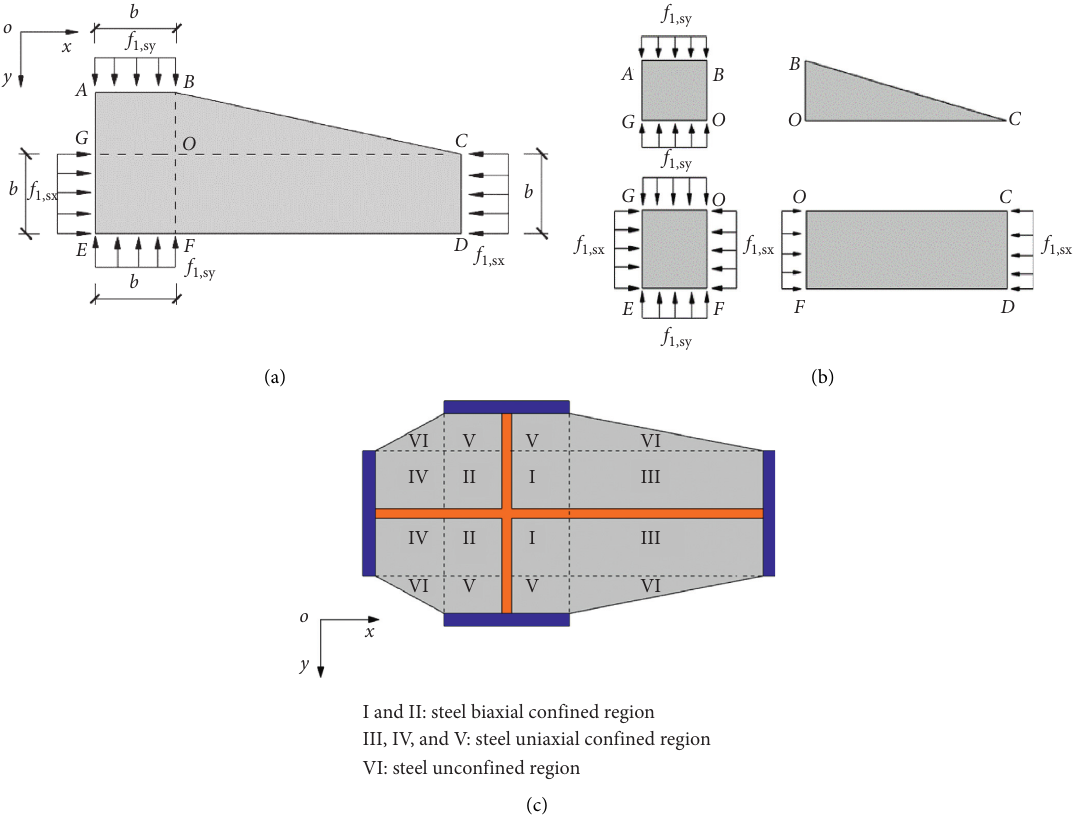
Figure 12: Regional partitioning of concrete in the SRCC-MCS-core column: (a) simplified stress state of the confined concrete, (b) simplified stress state of each confined concrete region, and (c) regional partitioning of confined concrete.